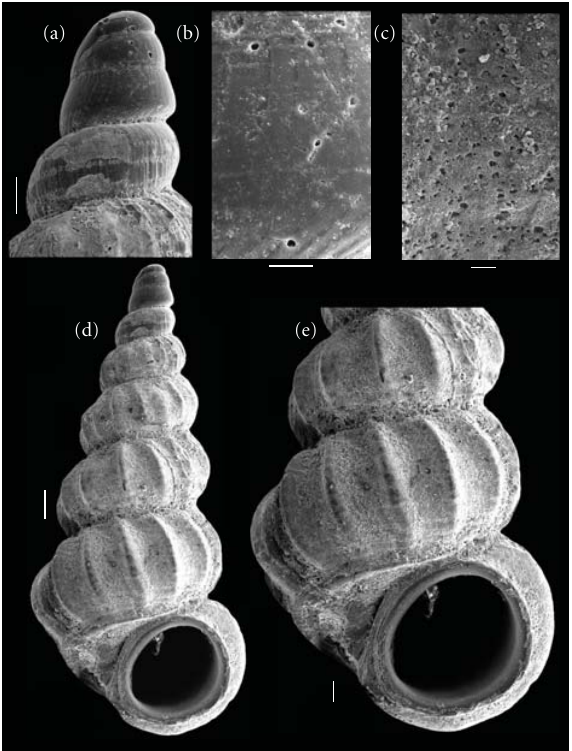
Figure 7: (a–e) Opalia abbotti (IBUFRJ 18.828); (a) protoconch, (b) detail of protoconch ornamentation, (c) detail of teleoconch ornamentation, (d) ventral view, and (e) view of last whorl and penultimate whorl. Scale bars: (a) 100 μ m, (b) 20 μ m, (c) 10 μ m, (d) 200 μ m, and (e) 100 μ